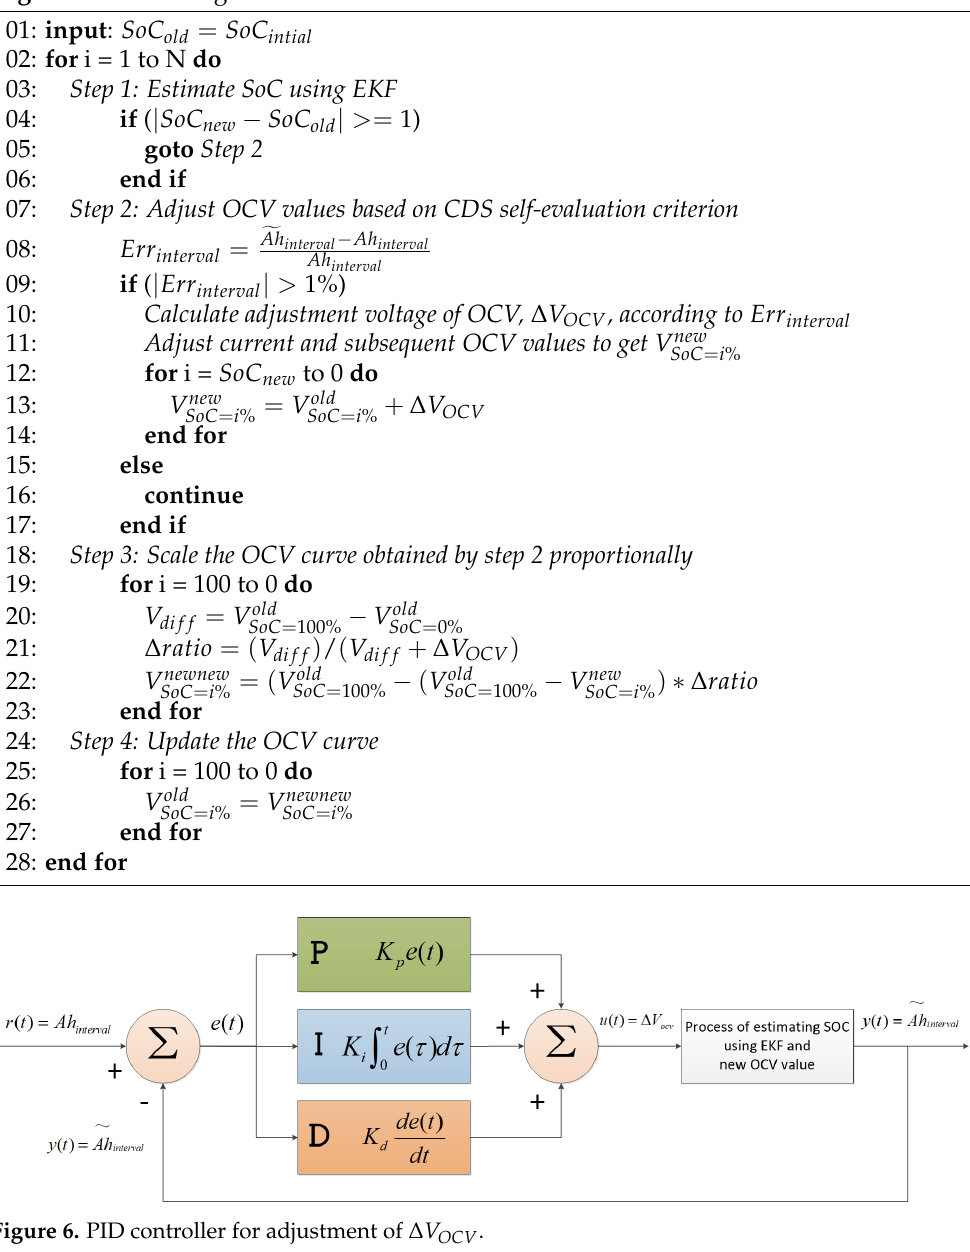
Algorithm 2 EKF Algorithm with CDS self-evaluation criterion